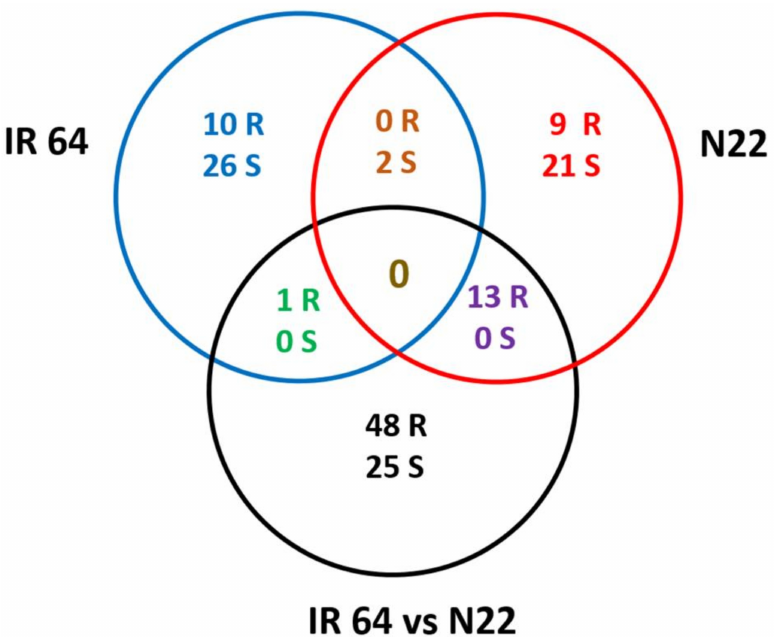
Figure 7. Venn diagram depicting the distribution of the DEGs identified under optimal (N+) and low N (N − ) from IR64, Nagina 22 and IR64 vs. N22 co-localized with the quantitative trait loci (QTL) regions governing nitrogen use efficiency in